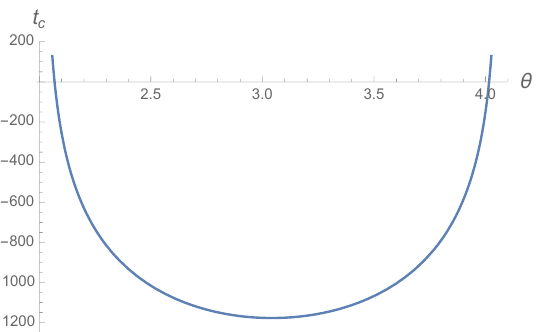
Figure 5. Plot of t c against θ for r = 0 . 1 , λ = 0 . 001 , sharply near the edges of the interval ( θ